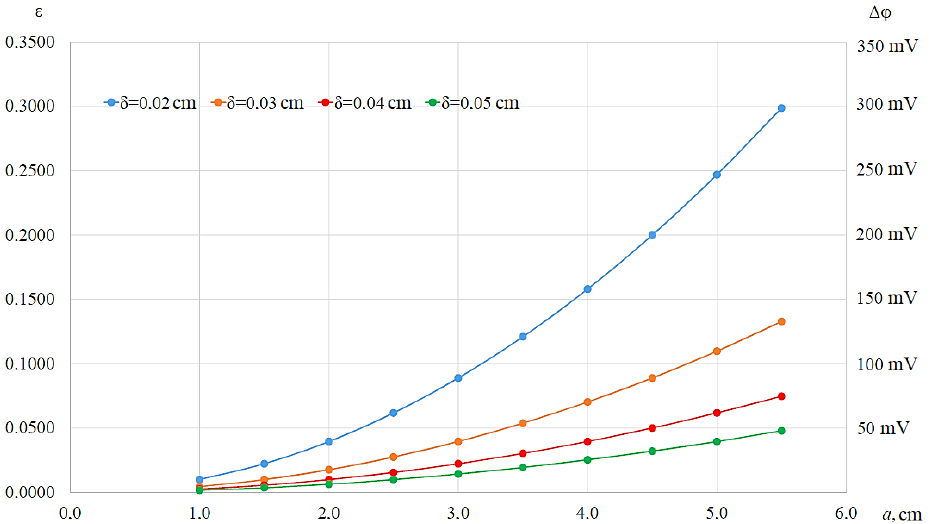
Figure 9. Graph of the dependence of the relative deformation of membranes ( ε ) and corresponding potential jump ( Δ φ ) on membrane radius ( a ) and thickness ( δ ).